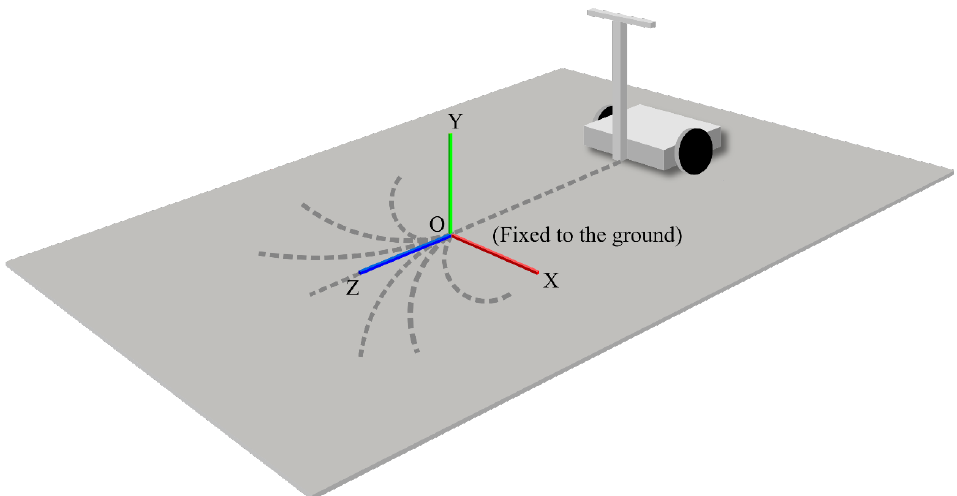
Figure 16. Absolute coordinate system.